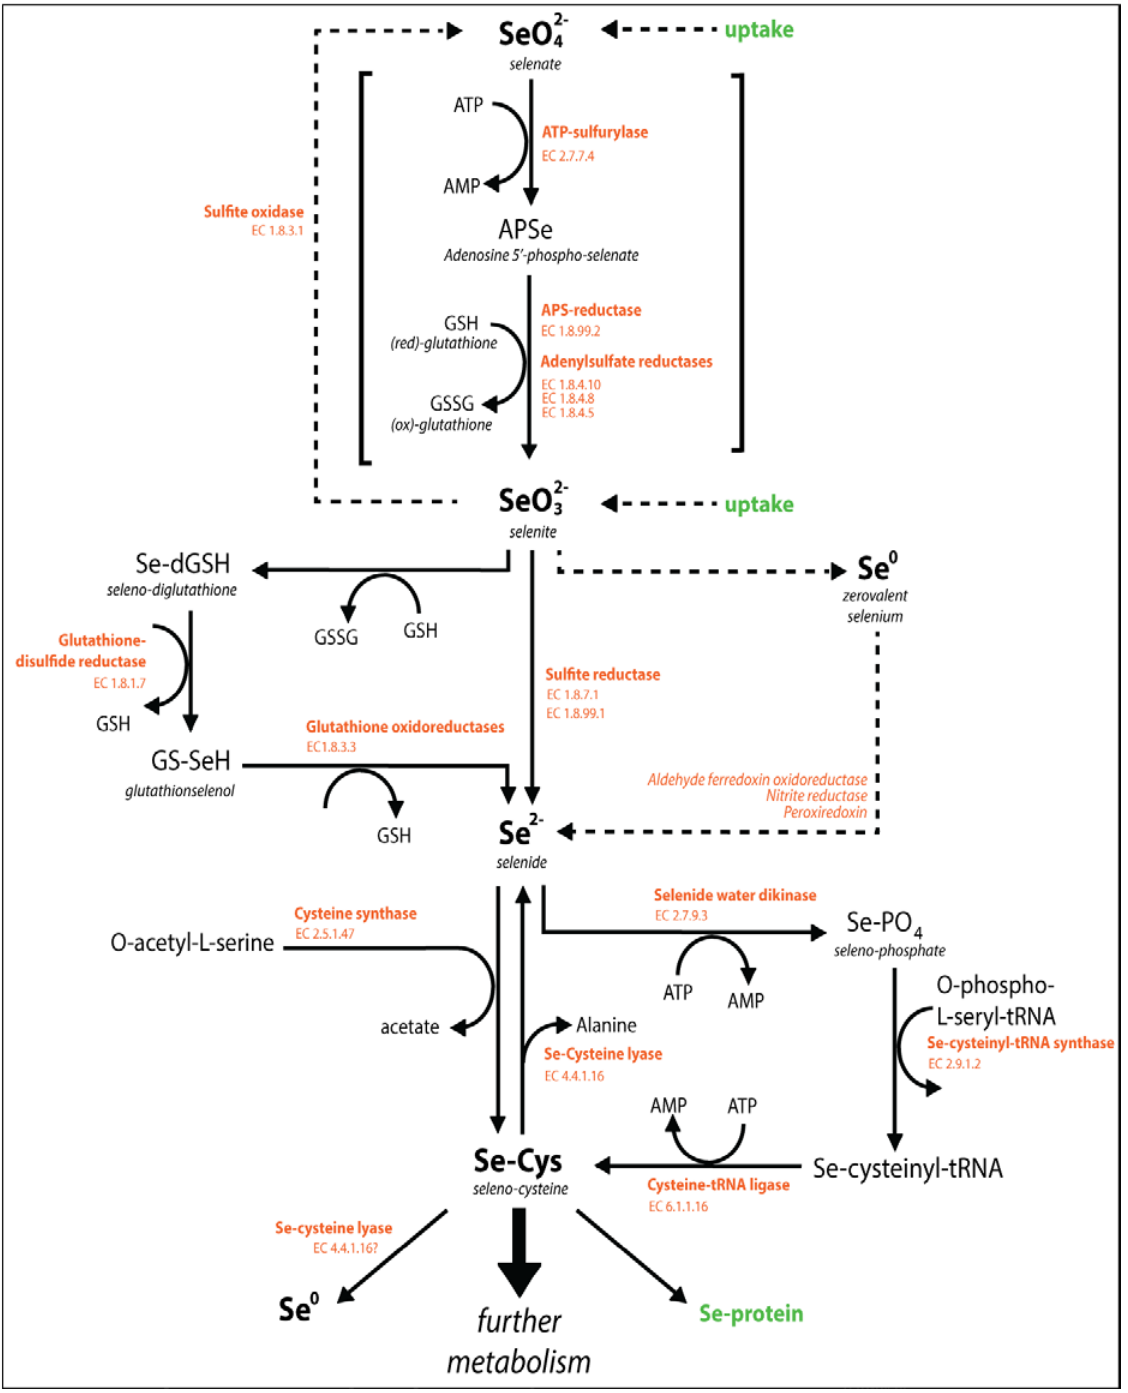
Figure 4. Schematic diagram of the biochemical reactions in the uptake and metabolism of Se in plants and microorganisms. Identified catalyzing enzymes and their Enzyme Commission (EC) numbers are indicated in orange at the corresponding reactions. Major (intermediate) compounds are indicated in bold. Information was compiled from previous reviews